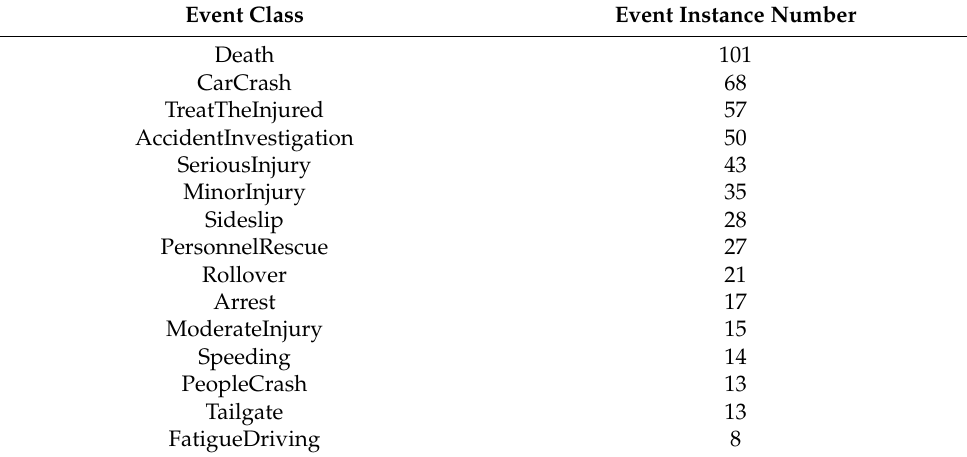
Table 2. Event classes and data